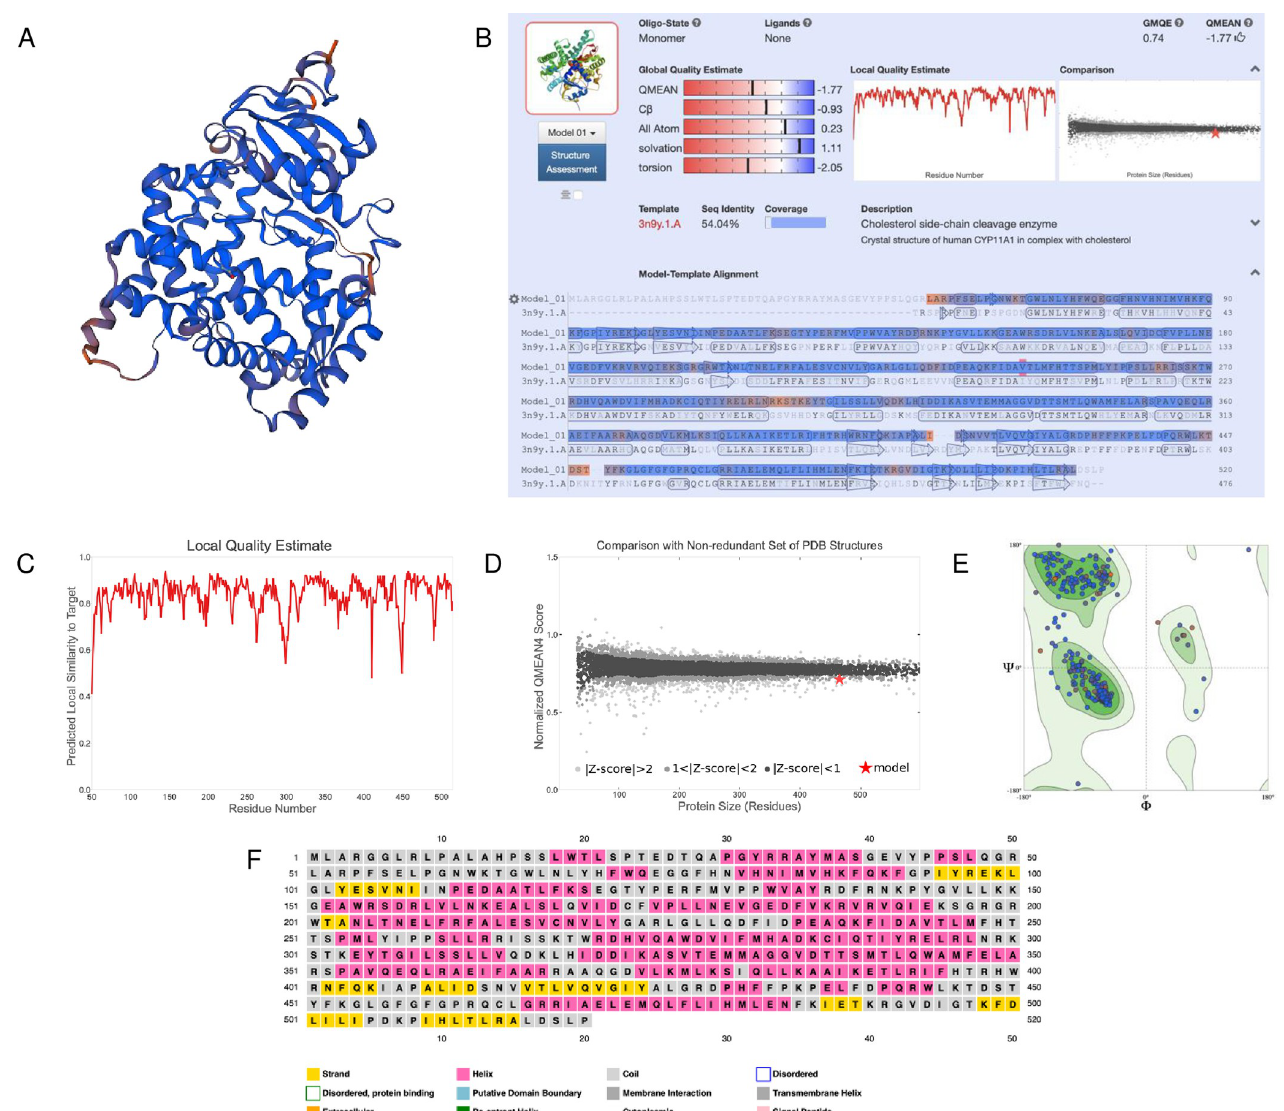
Fig 4. Homology modeling and structural predictions of the mitochondrial cholesterol side-chain cleavage enzyme. (A) Three-dimensional homology model built by SWISS-MODEL. Blue regions are highly conserved, while orange regions are less conserved. (B) Oligo-state, ligands, global quality estimates, template, sequence identity, and coverage outputted by SWISS-MODEL. (C) Local quality estimate showing pair residue estimates. Similarities > 0.6 are high- quality models. (D) Comparison with non-redundant set of PDB structures showing QMEAN scores for experimental structures that have been deposited of similar size. The red star is our model. (E) Ramachandran plot showing the probability of a residue having a specific orientation. Dots in the dark green regions represent high probability and a high-quality model. (F) Secondary structure prediction through PSIPRED. https://doi.org/10.1371/journal.pone.0268031.g004 methylmalonyl-CoA epimerase (Fig 6A), which concurred with BLAST (Fig 5B). The protein belonged to the methylmalonyl-CoA epimerase family (IPR017515) with metal and substrate binding sites and dimer interfaces (Fig 6A). The protein was also predicted to be a part of the VOC domain (IPR037523) and glyoxalase/bleomycin resistance protein/dihydroxybiphenyl dioxygenase homologous superfamily (IPR029068, Fig 6A). There were also predictions of a signal peptide and non-cytoplasmic domains (Fig 6A). No GO terms were outputted on Inter- Pro; however, two GO terms outputted by AmiGO 2 were the biological process L-